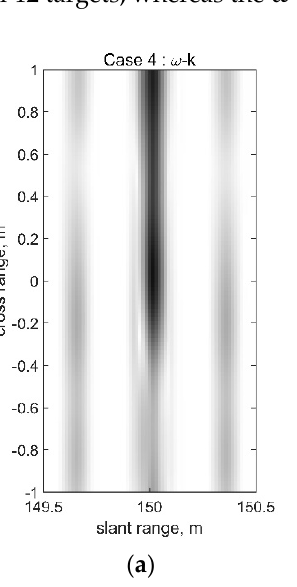
Figure 8. Simulation results for Case 4 for single sensor: ( a ) result for the ω -k algorithm; ( b ) result for the CS-SAS algorithm for single sensor.